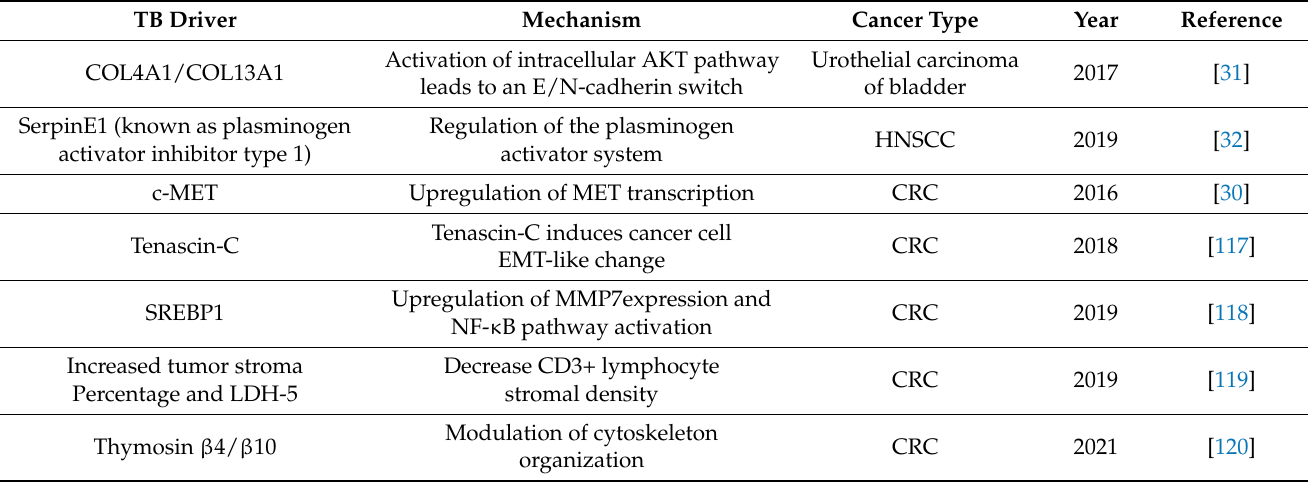
Table 1. Other evidence of TB